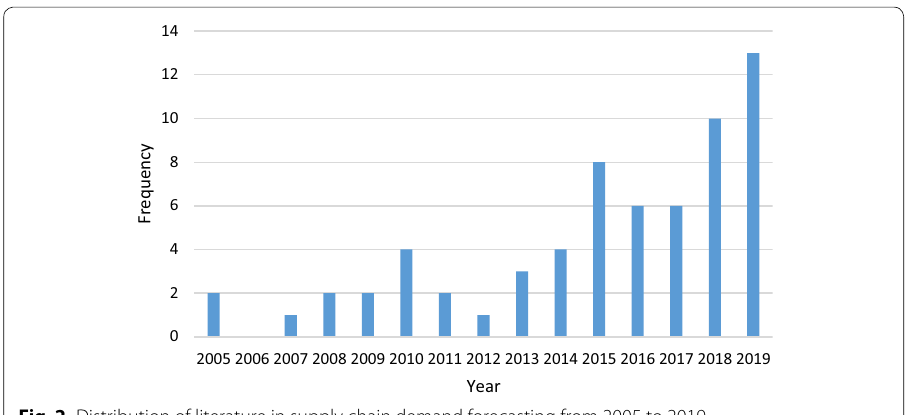
Fig. 2 Distribution of literature in supply chain demand forecasting from 2005 to 2019